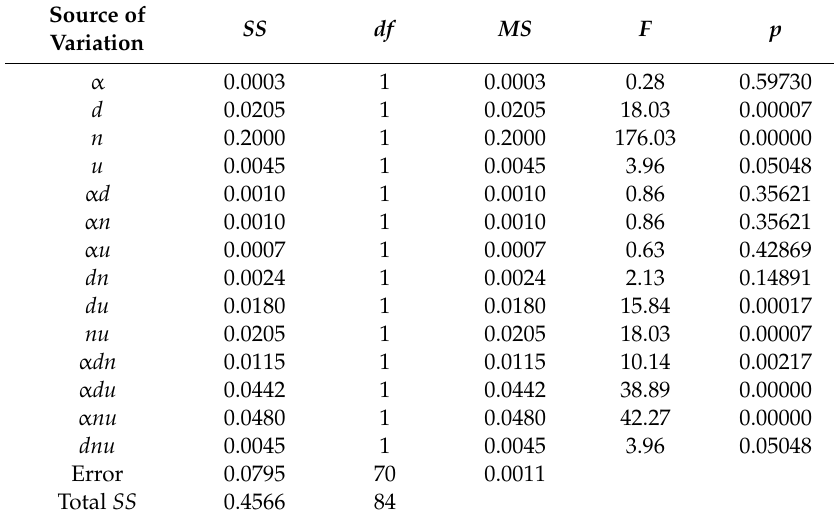
Table 2. Model of melt flow rate (MFR)–ANOVA table. R 2 = 0.82; R adj2 =